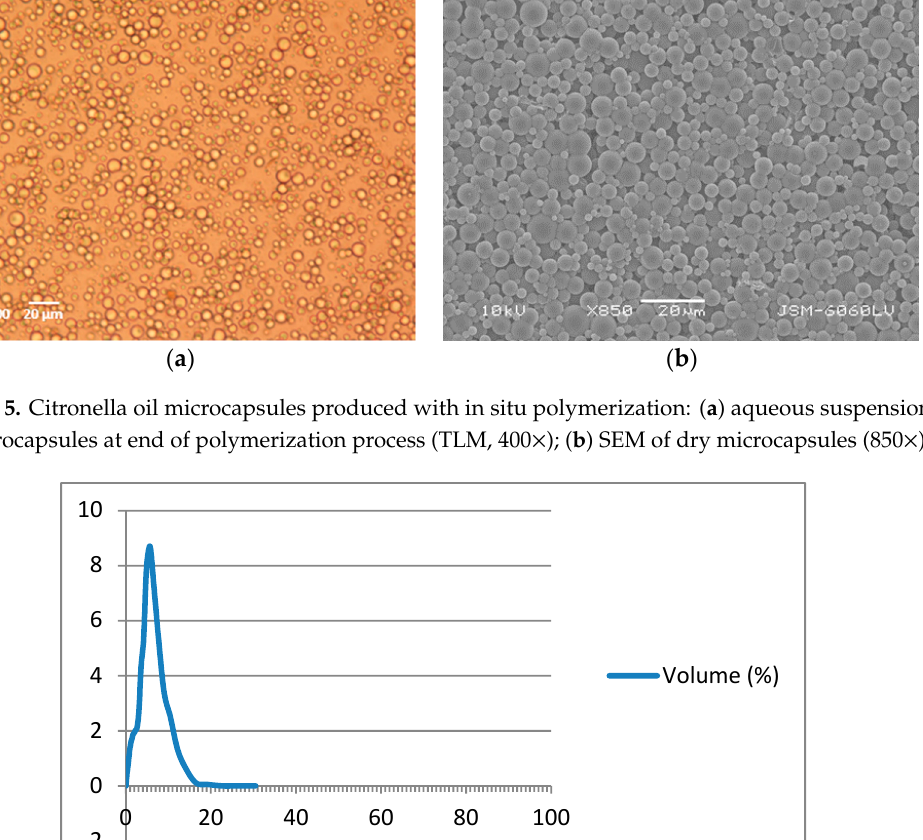
Figure 7. Paper coated with a formulation containing microcapsules (2 g/m 2 ): ( a ) coacervation microcapsules (SEM, 1000×); ( b ) in situ polymerization microcapsules (SEM, 1000×).